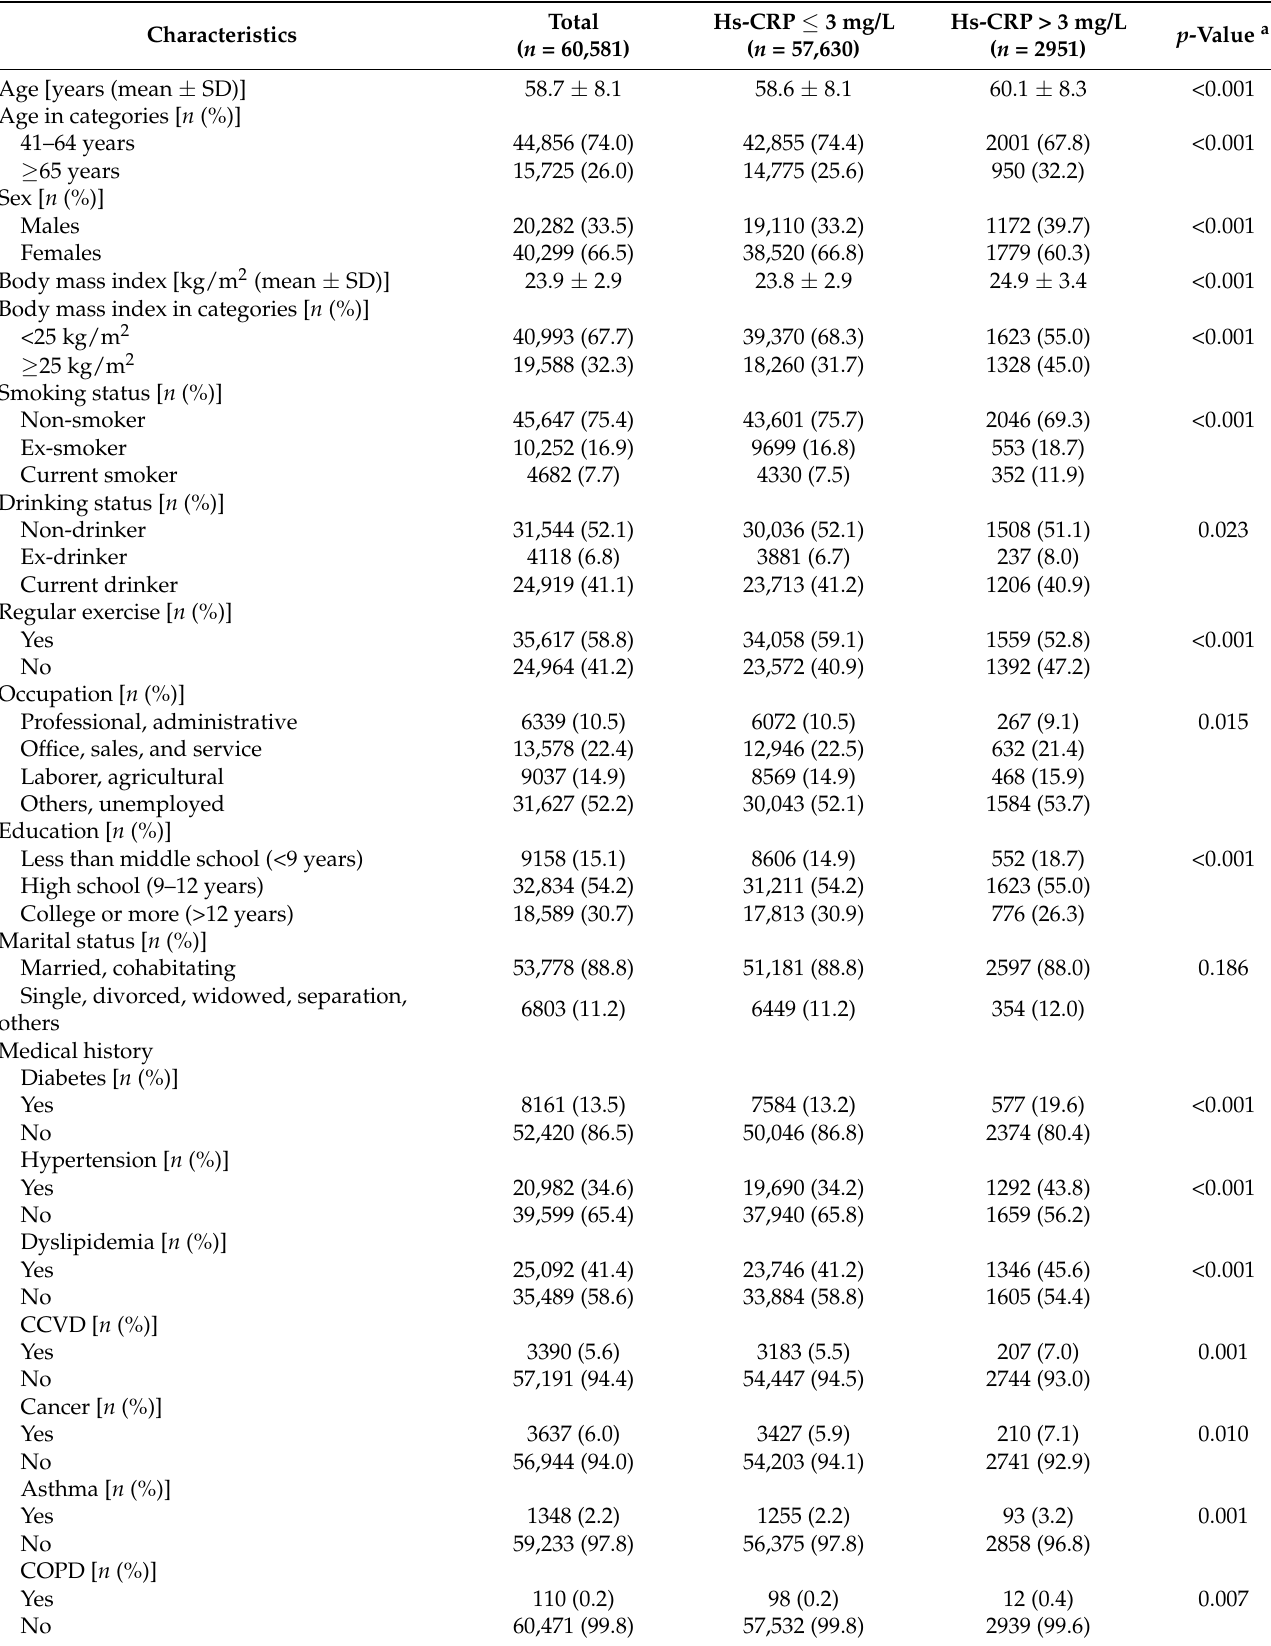
Table 1. General characteristics of the study